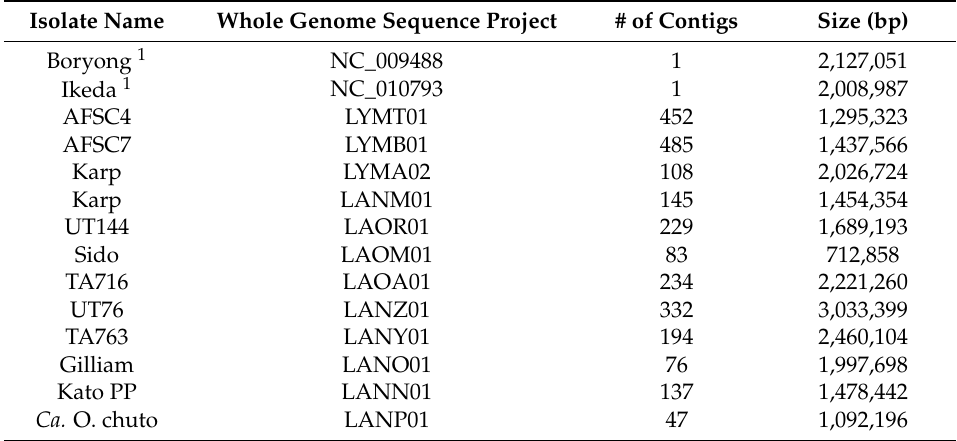
Table 1. Genome Sizes of Completed Genomes and of Genome Assemblies of Isolates of Orientia